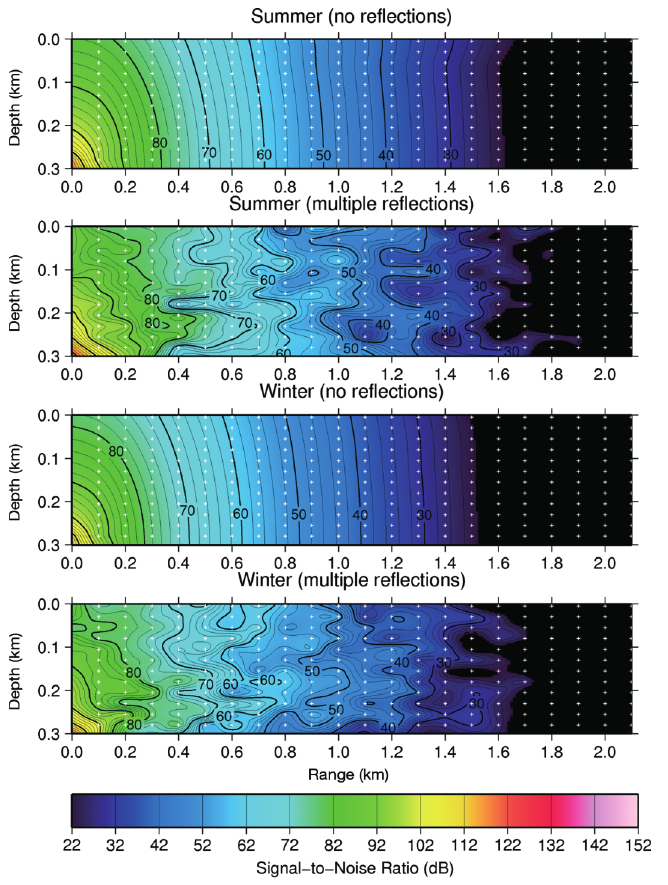
Fig. 8. The signal-to-noise ratio for the summer and winter months in the Gulf of Naples with the transmitter positioned at a depth of 299 m. The receiver grid is plotted with white dots. For this source depth the negative velocity gradient of the summer months no longer influences communication, but the influence of the seafloor is